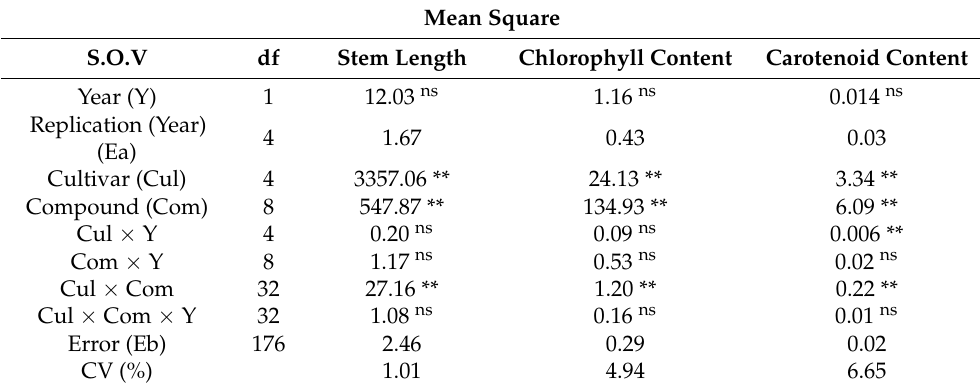
Table 2. Analysis of variance on the effects of chitosan and titanium dioxide treatments (bulk, nanoparticles) on stem length and leaf photosynthetic pigment content of five milk thistle ecotypes.